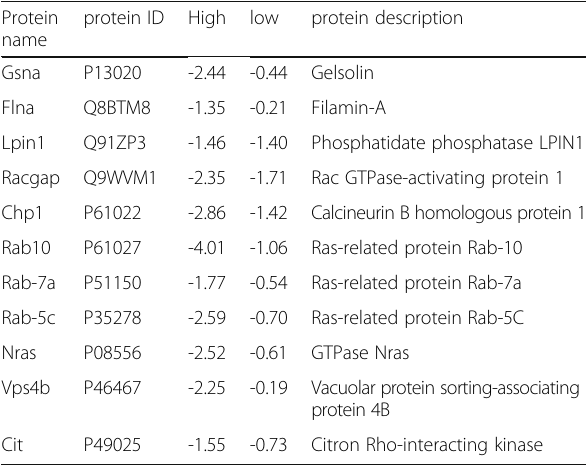
Table 4 Effect of SS on expression of cytoskeleton organization and intra-cellular transportation related